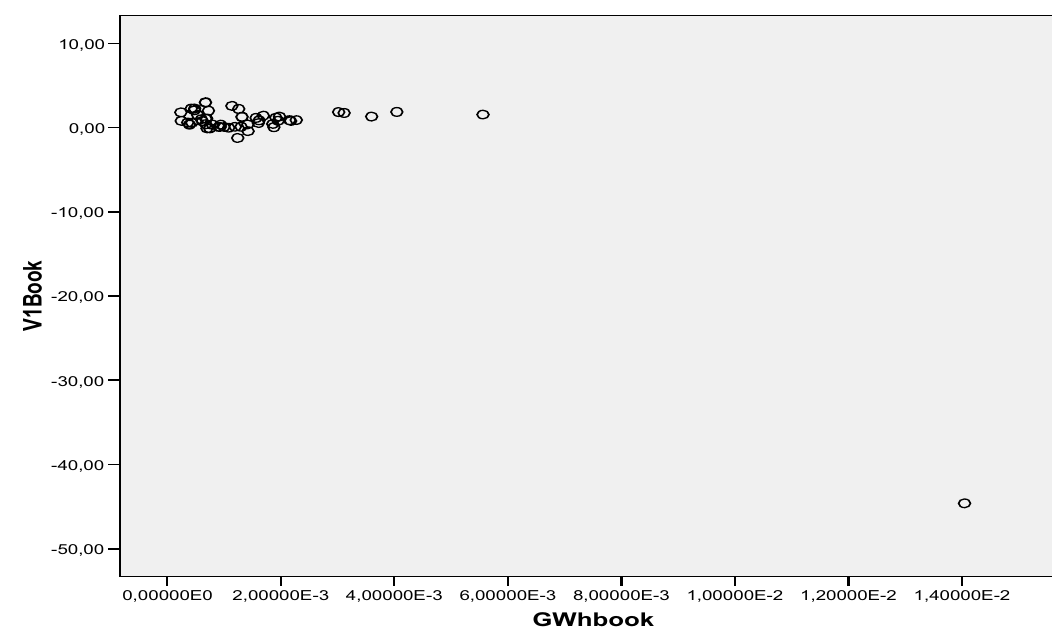
Fig. 3. Scatter plot of the GWh/Book variable with the V1/book variable in eq. (10a) and